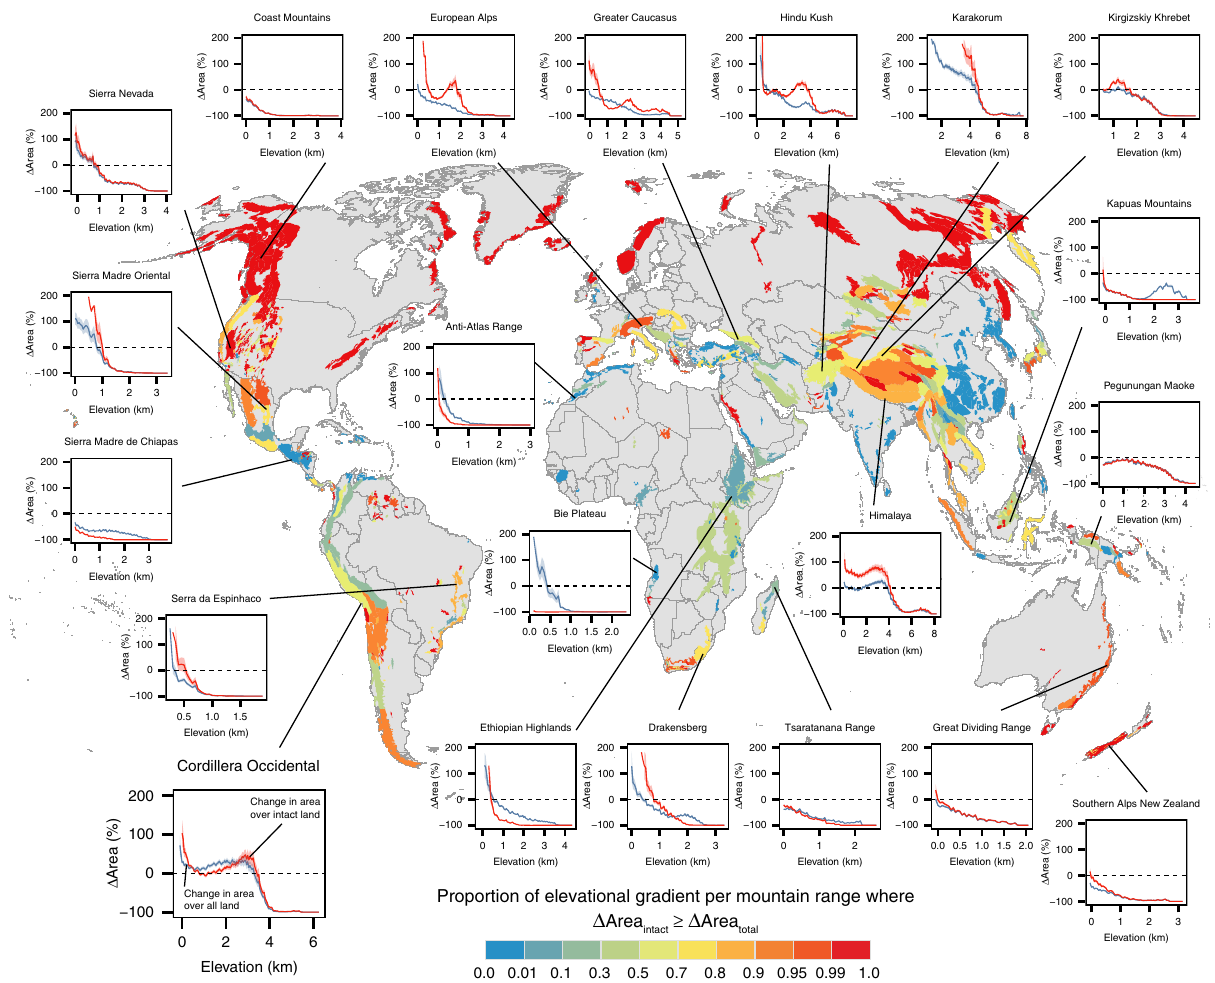
Fig. 2 Comparing projected area from modeled elevational range shifts with and without accounting for human pressure. Map of global mountain ranges shows the proportion of the elevational gradient for each range where percentage of change in intact area equals or exceeds the percentage of change in total area following range shifts for a suite of modeled hypothetical montane species. Range shifts are calculated using mountain range-speci fi c rates of mean annual temperature change averaged across 17 GCMs for RCP 8.5 in 2070, mountain range-speci fi c adiabatic lapse rates, and varying elevational range sizes for hypothetical species (see “ Methods ” section and Supplementary Fig. 9 for descriptive and schematic overviews of the modeling procedure). Insets for select mountain ranges show mean and standard error percentage of changes in area across all modeled species in two cases, one where species are allowed to occupy all land area (blue lines Δ Area total ), and one where species only occupy intact land area (red lines Δ Area intact ). Values of – 100% signify that the species have no available total or intact land area remaining and face local extinction. The x -axis elevation represents the lower boundary of elevation prior to the range shift. See the plot for Cordillera Occidental for a detailed legend to other insets. Therefore, the global map depicts the proportion of each mountain range ’ s elevational gradient where the change in area in the second case equals or exceeds the change in area in the fi rst case (i.e., the proportion of elevation where the red curve equals or exceeds the blue curve). See also Supplementary Data 1 for analogous inset plots for all mountain ranges ( n = 1010) and Supplementary Fig. 7a for the analogous global map using RCP 4.5. (Fig. 3a). For example, modeled range shifts where species closely track shifting isotherms in the European Alps in the fi rst case led to continued reductions in projected area available for species as total land area tended to decline monotonically with elevation (Fig. 2 inset, blue line). However, in the second case, the modeled range shifts in the European Alps led to area gains up until about 600 m and then again from 1500 to 2500 m, due to shifting away from areas under greater human pressure at lower elevations (Fig. 2 inset, red line). At higher elevations (>2500 m), species encountered area reductions in both cases owing largely to topographic constraints. However, average responses across all modeled species (i.e., across all elevational range class sizes considered) were variable across mountain ranges and there were some notable excep- tions to this general trend described above. For example, in roughly 1000 m on pyramid mountains. This was true in both the NATURE COMMUNICATIONS| (2020) 11:1974